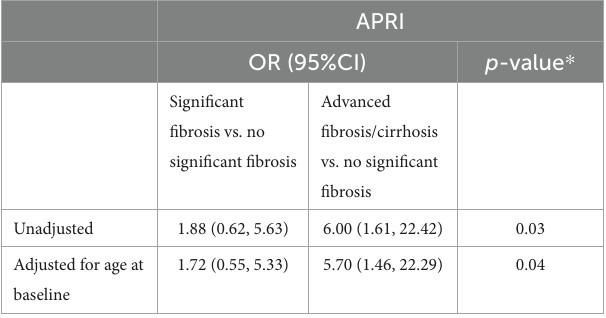
TABLE 3 Odds ratios (ORs) and 95% confidence intervals (CIs) for the association between HDV and fibrosis category (based on APRI values at enrollment) among WIHS participants with active HBV infection ( n =